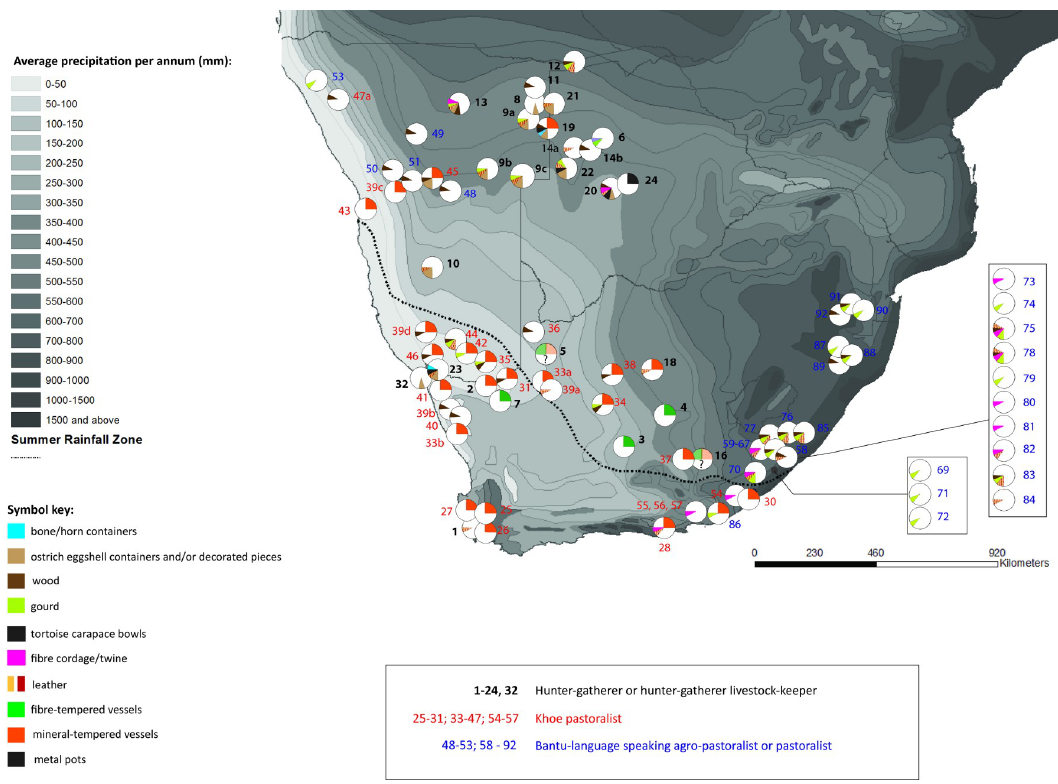
Fig 9. Map to show the ethnographic and historic observations of container use from AD 1600